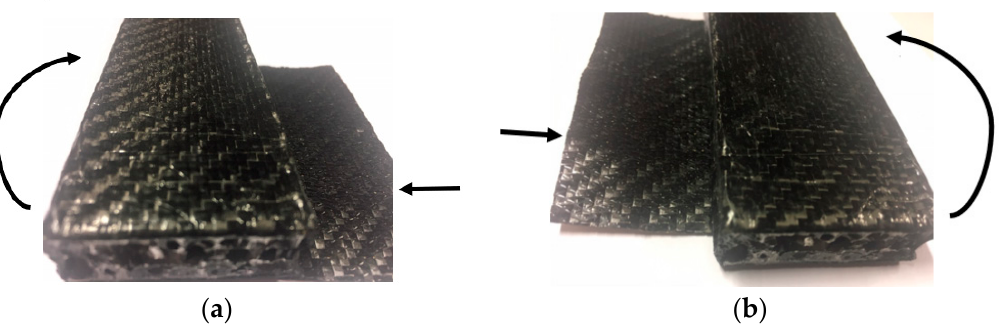
Figure 7. ( a ) Wrapping direction for first and third CFRP layers; ( b ) wrapping direction for second and fourth CFRP layers.